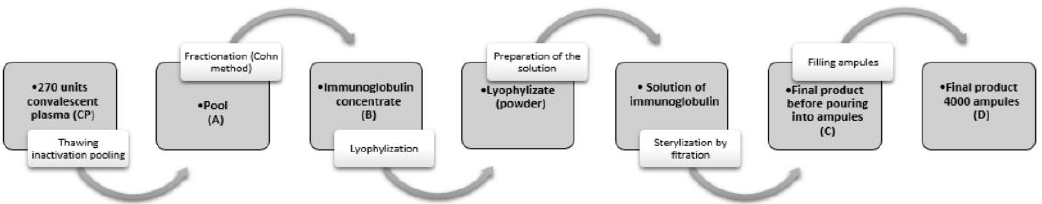
Figure 1. hIHGG anti-SARS-CoV-2 production.